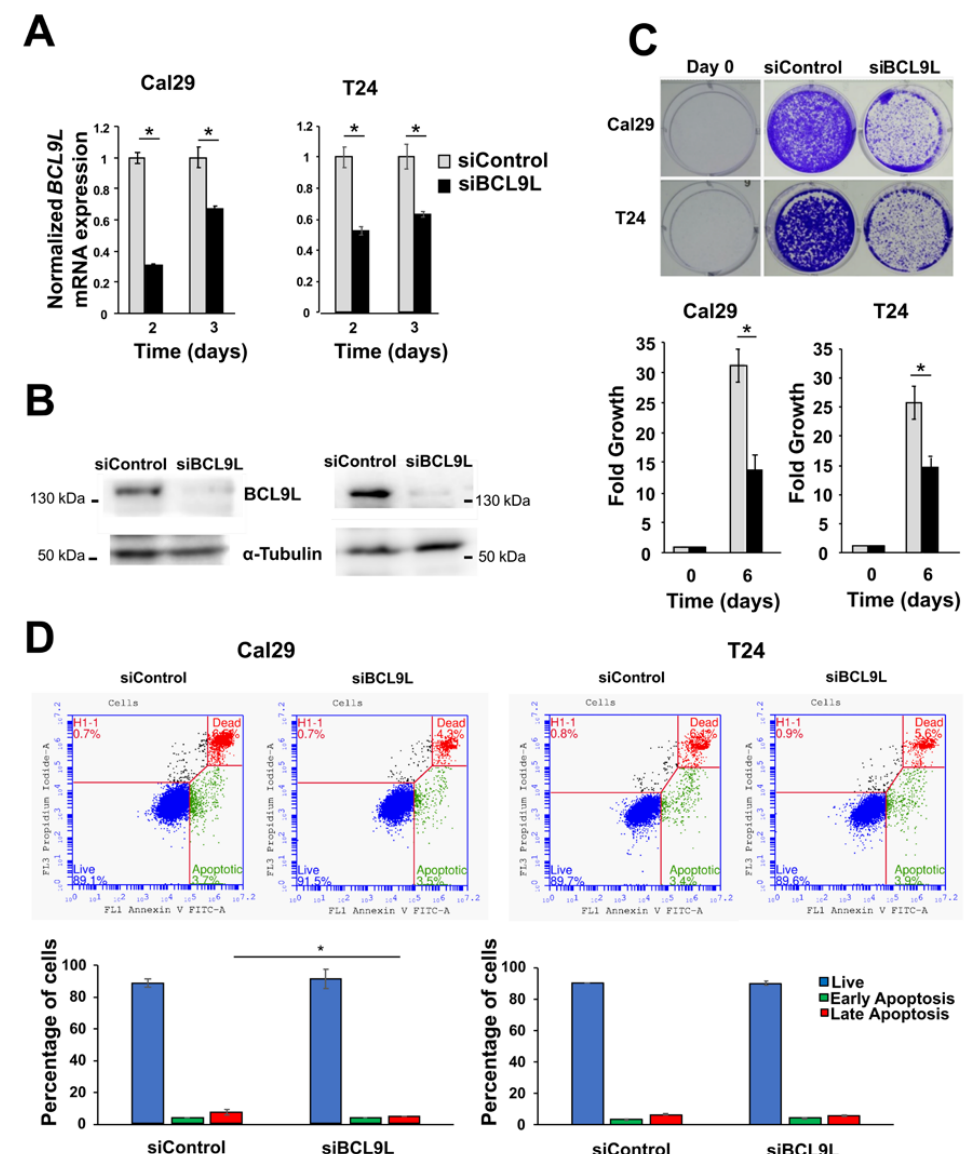
Figure 3. Cell proliferation and apoptosis analysis of bladder cancer after BCL9L knockdown. ( A ) mRNA expression of BCL9L after knockdown by qRT-PCR in Cal29 ( n = 4) and T24 ( n = 4) cells. siControl was set as 1 arbitrarily. ( B ) The protein level of BCL9L of transfected cells siBCL9L and siControl after 3 days transfection. ( C ) Cell proliferation is significantly reduced in BCL9L knockdown cells, analysed by crystal violet staining assay ( n = 4) ( D ) BCL9L knockdown did not affect apoptosis of BC cells. The apoptosis assay was performed by dual staining with annexin V-FITC and propidium iodide (PI) kit and analysed by flow cytometry. * p -value < 0.05 Mann–Whitney U -test, n = independent